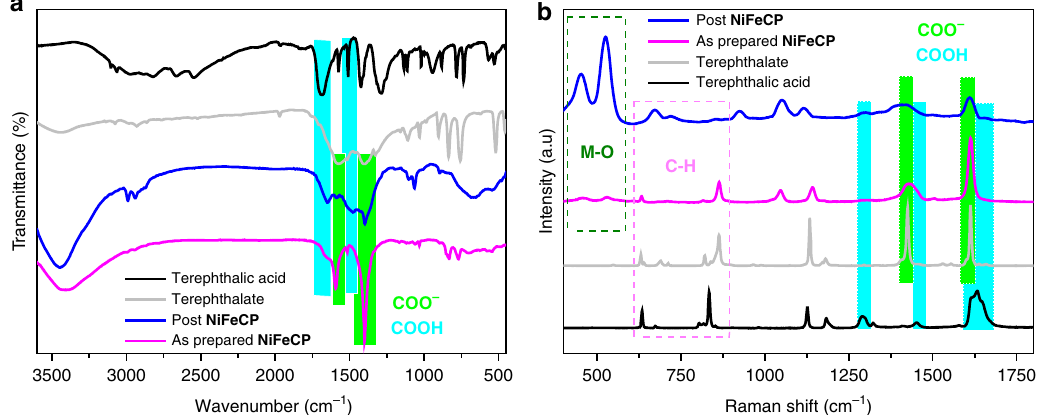
Fig. 5 FT-IR and Micro-Raman measurements. a FT-IR spectra of dried NiFeCP powder scratched from the electrode before and after OER. b Micro-Raman spectra of NiFeCP/NF electrode before and after OER. Terephthalic acid and Na terephthalate as